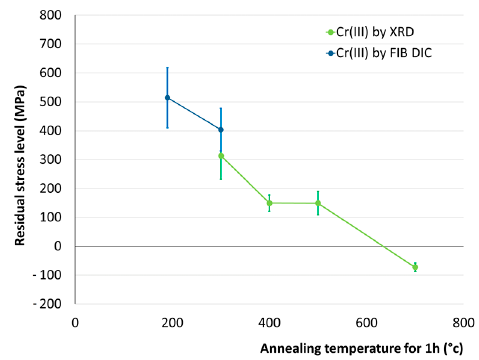
Figure 11. Evolution of stress level on the Cr(III) coating with annealing temperature, as determined by the FIB-DIC and XRD techniques.